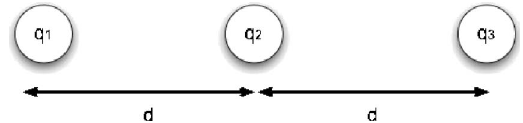
FIG. 10. Figure for the three-charge problem.